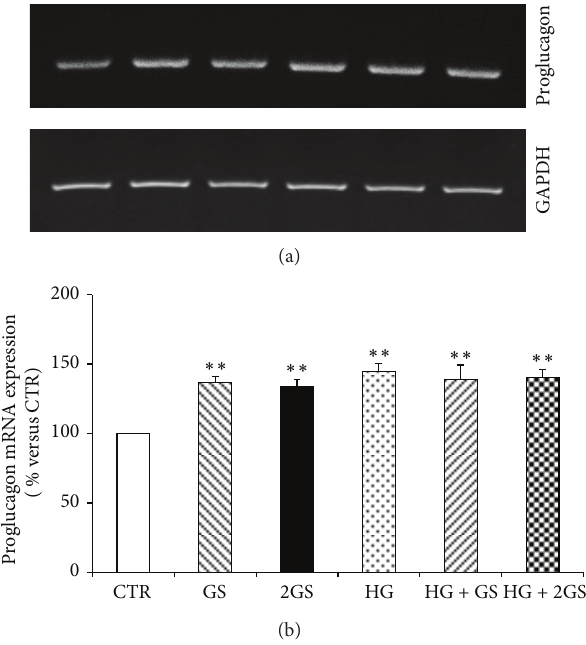
Figure 2: GS and HG increase proglucagon mRNA expression. Semiquantitative RT-PCR of proglucagon mRNA expression in GLUTag cells stimulated standard medium (CTR) or high glucose concentration (25mmol/L) (HG) in presence of different concen- trations of glycated serum (400 [GS] and 800 nmol/L [2GS]). (a) Representative agarose gel. (b) Quantification of densitometries of agarose gel bands. Data are represented as mean ± SE ( 𝑛 = 3 ). ∗∗ 𝑃 < 0.01 versus CTR. glucose concentration (Figures 4(a) and 4(b)). On the other hand, PC 1/3 was significantly upregulated by HG incubation